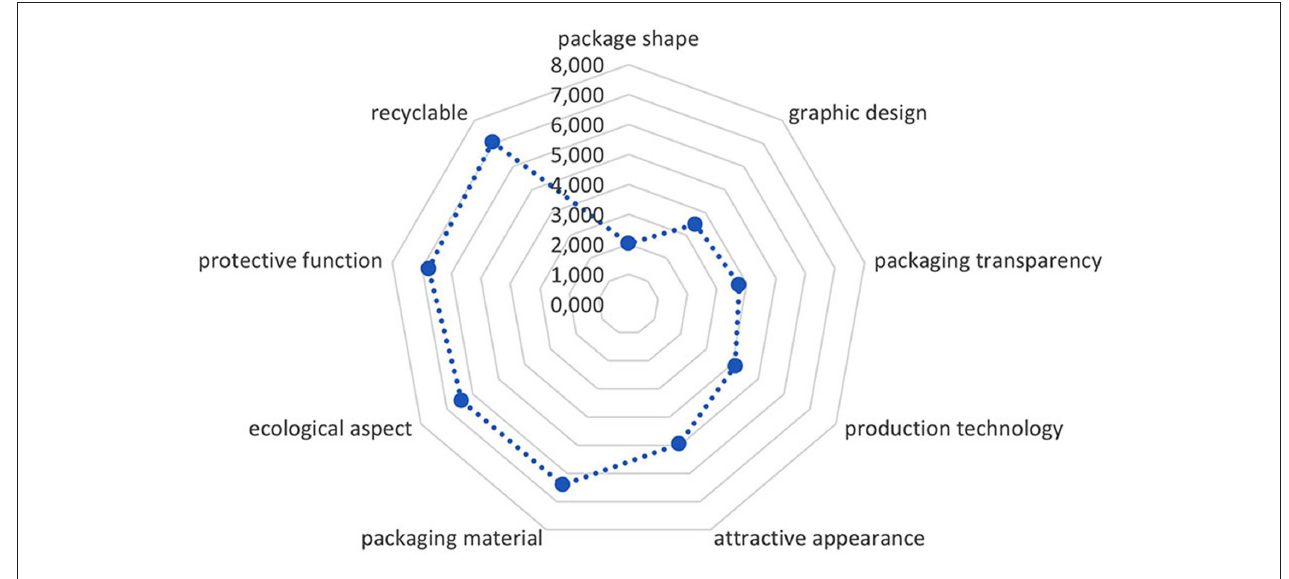
FIGURE 2 | Factors of packaging